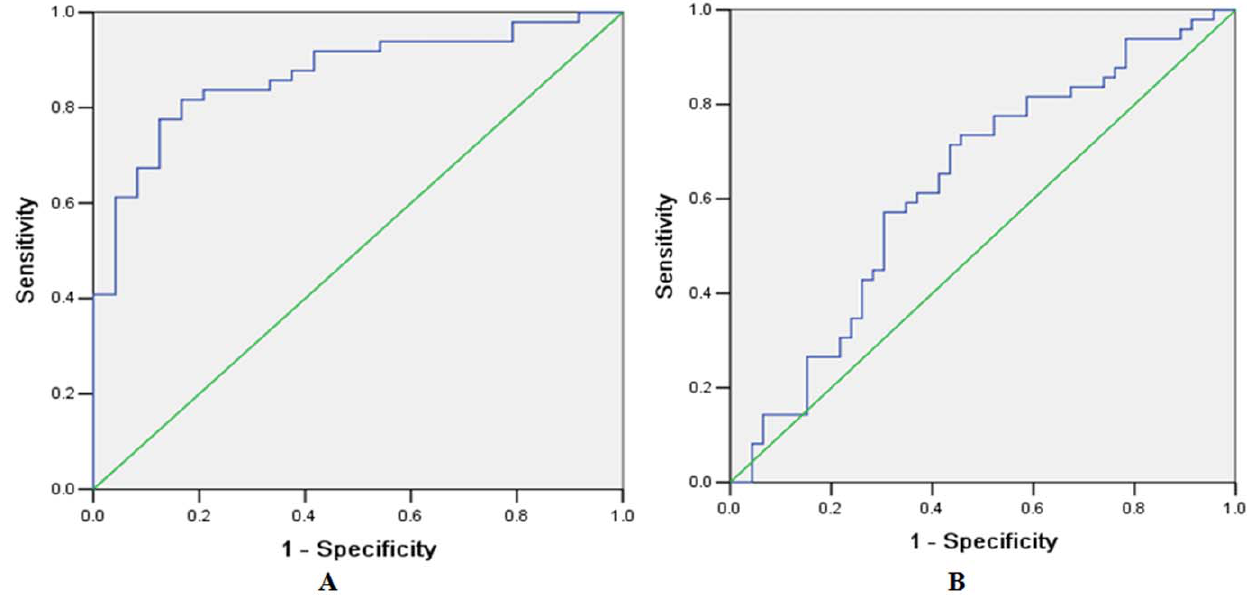
Figure 4. Receiver operating characteristics (ROC) curve analysis using serum miR-122 for discriminating HCC patients from healthy controls and HBV patients without HCC. Serum miR-122 yielded an AUC (the areas under the ROC curve) of 0.869 (95% CI: 0.786–0.952) with 81.6% sensitivity and 83.3% specificity for discriminating HCC patients from healthy controls (A), and an AUC of 0.630 (95% CI: 0.516–0.743) with 77.6% sensitivity and 57.8% specificity for discriminating HBV patients with HCC from those patients without HCC (B).